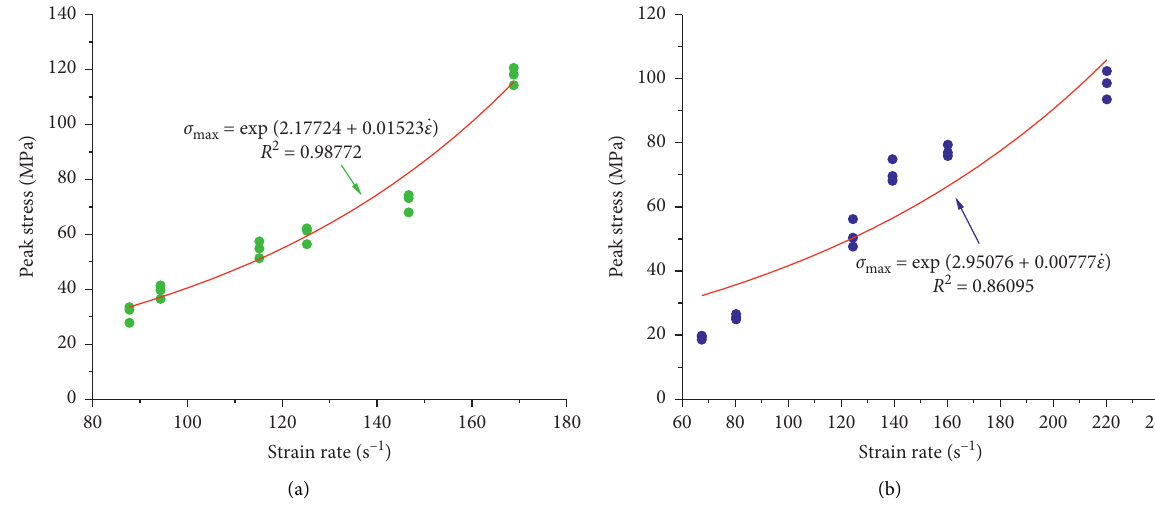
σ = exp (2.17724 + 0.01523 ε ) max R 2 = 0.98772